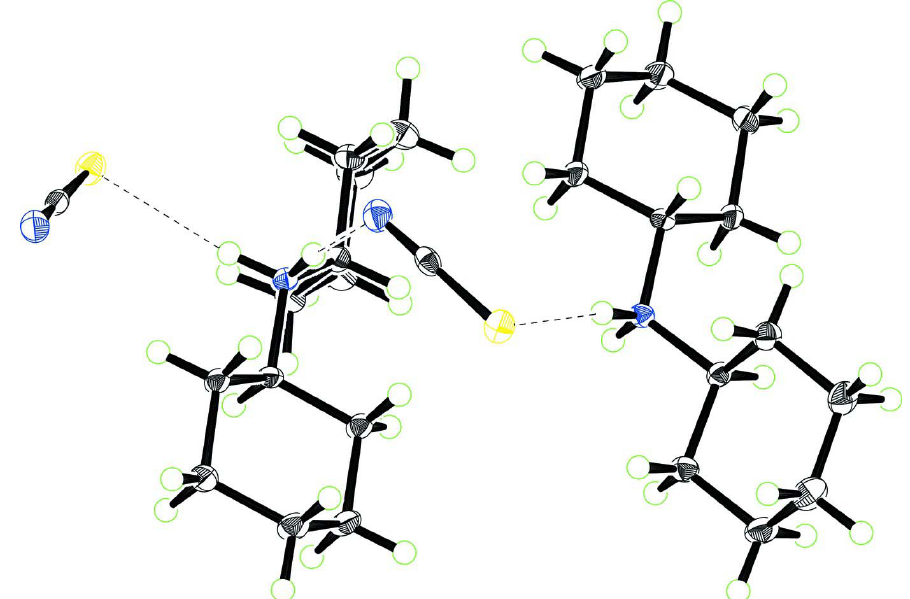
Figure 2 Showing hydrogen bonded anion to the cation through N—H···N and N—H···S. Dicyclohexylammonium thiocyanate Crystal